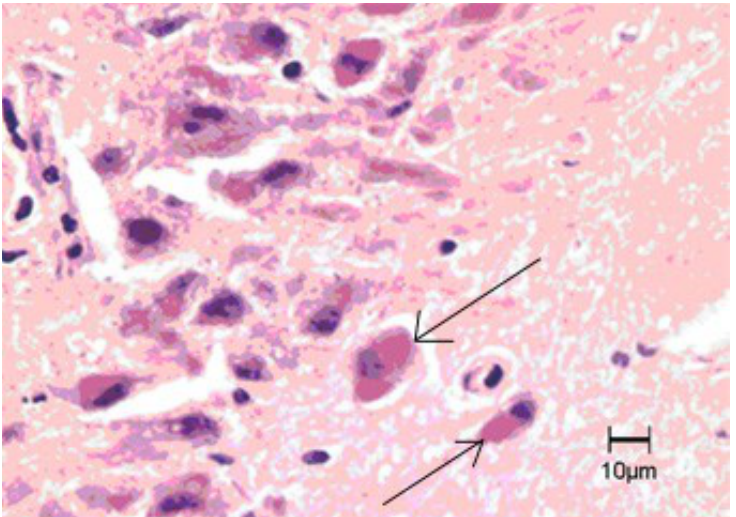
Figure 7: Histological section from the hippocampus of AIRmax mice. Arrows indicate the Negri